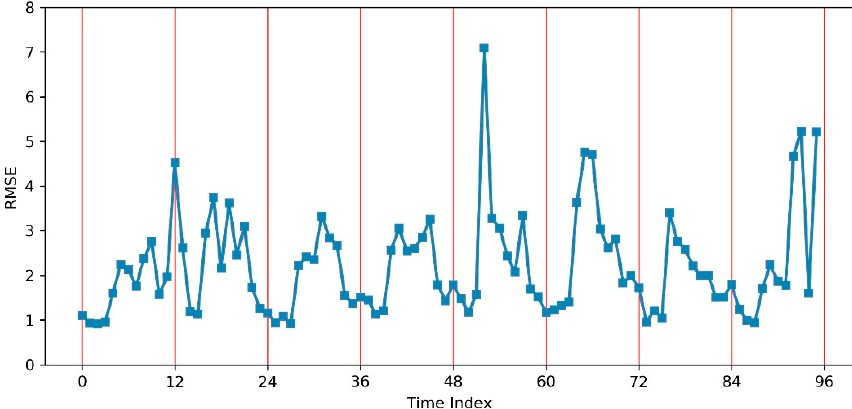
Figure 12. The relationship between the test data (blue circle) and prediction results (red circle) for the eight split groups ( a ) to ( h ), following the order from Figure 11, from top to bottom.